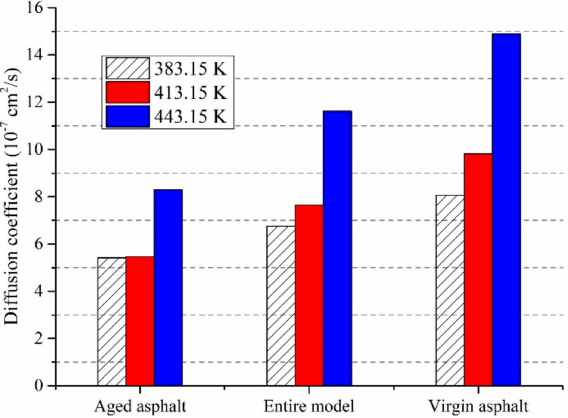
Figure 6. Diffusion coefficients at different